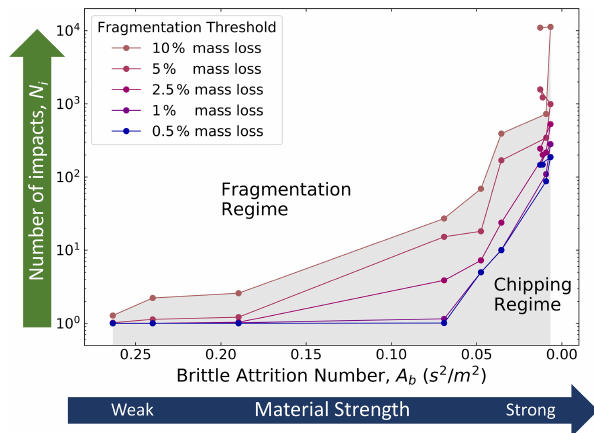
Figure 11. Experimentally determined phase space for attrition showing the approximate number of impacts required to fragment particles of different material strength. The fragmentation thresh- old, or boundary between the chipping and fragmentation regimes, is defined by the fraction of mass lost during a given impact (e.g., fragmentation occurs if 10% of a particle’s current mass is